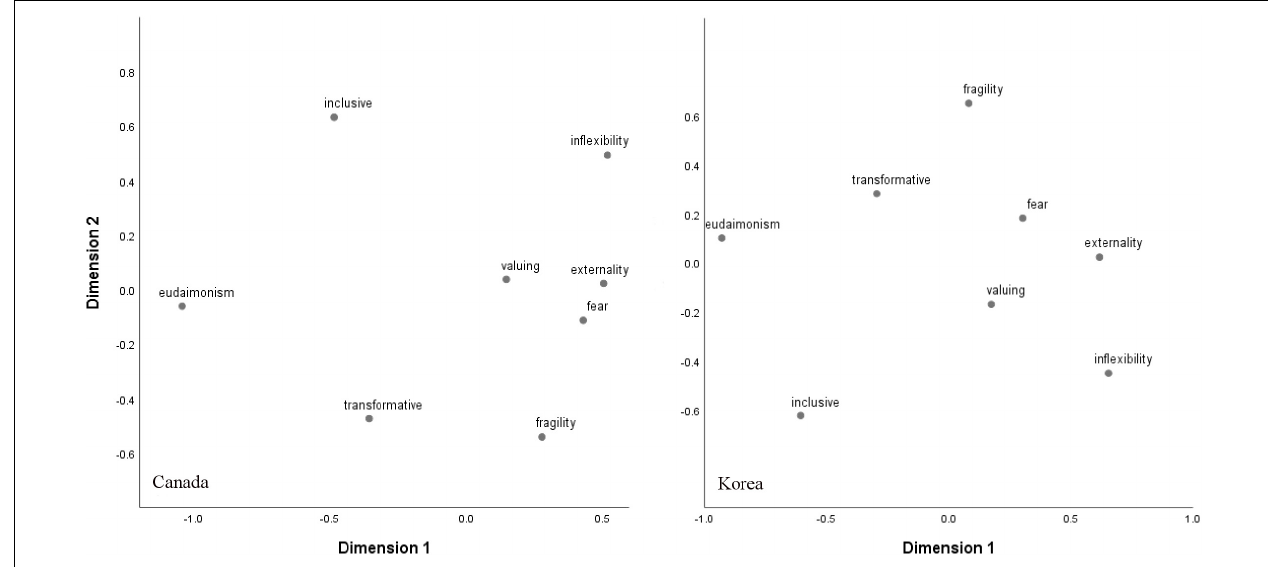
FIGURE 1 | Multidimensional scaling plots of conceptions of